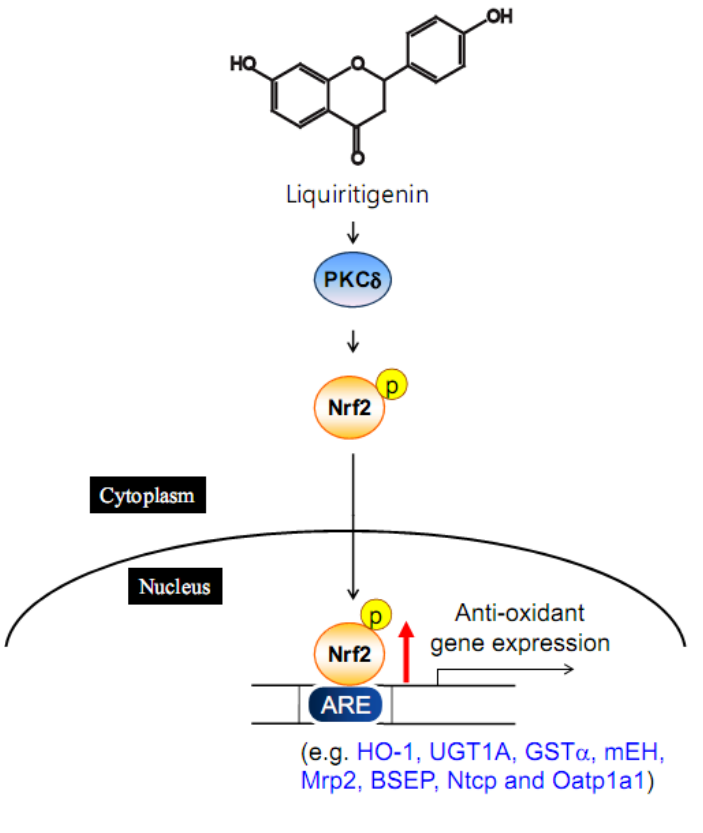
Figure 2. The induction of phase II enzyme and phase III transporters by